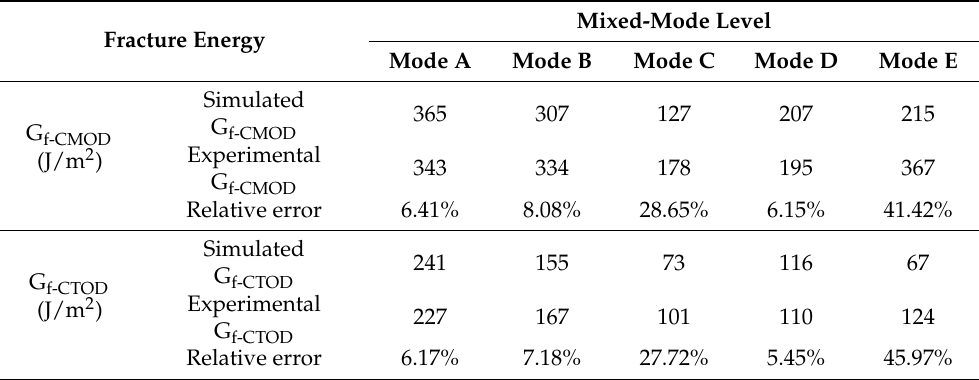
Table 2. Comparison between experimental fracture energies and the simulated